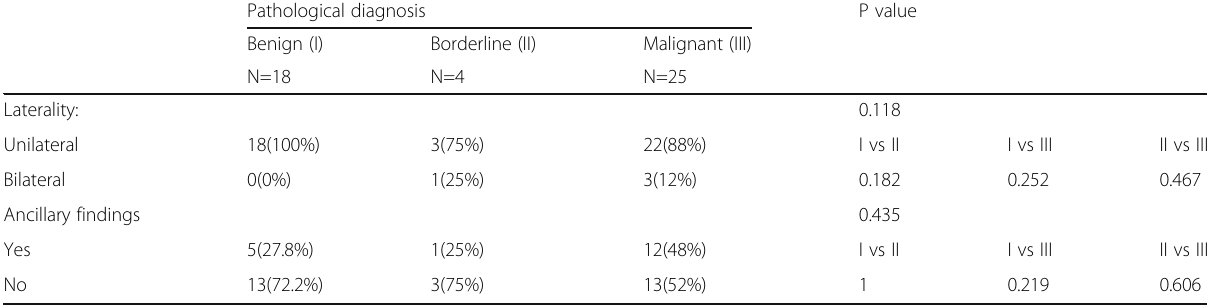
Table 3 Conventional MRI findings with correlation to pathological final diagnosis Pathological